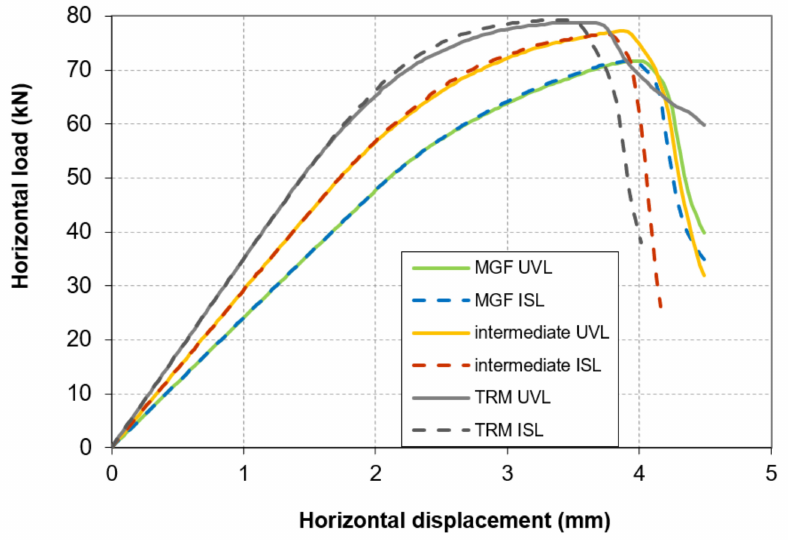
Figure 13. Influence of the in-situ stress: force vs. displacement curves for the tested loading